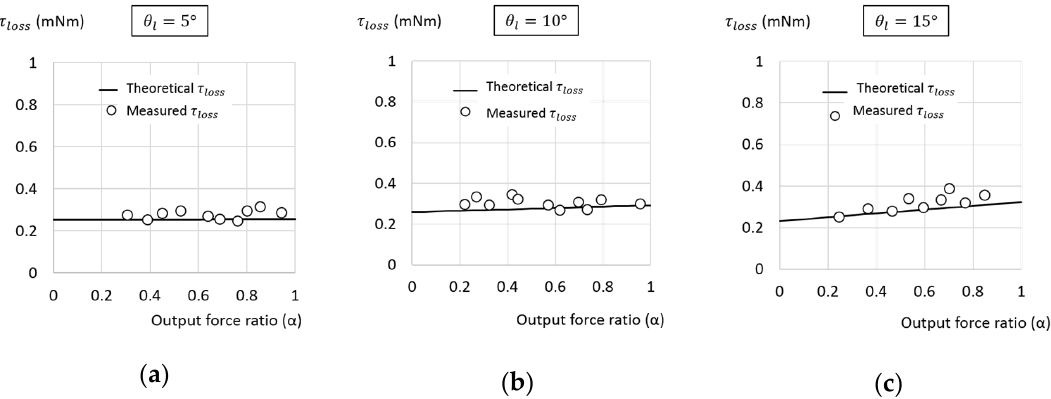
Figure 11. The theoretical and measured torque loss ( τ loss ) under di ff erent output force ratio for lead angle of ( a ) 5 degrees; ( b ) 10 degrees; and ( c ) 15 degrees.